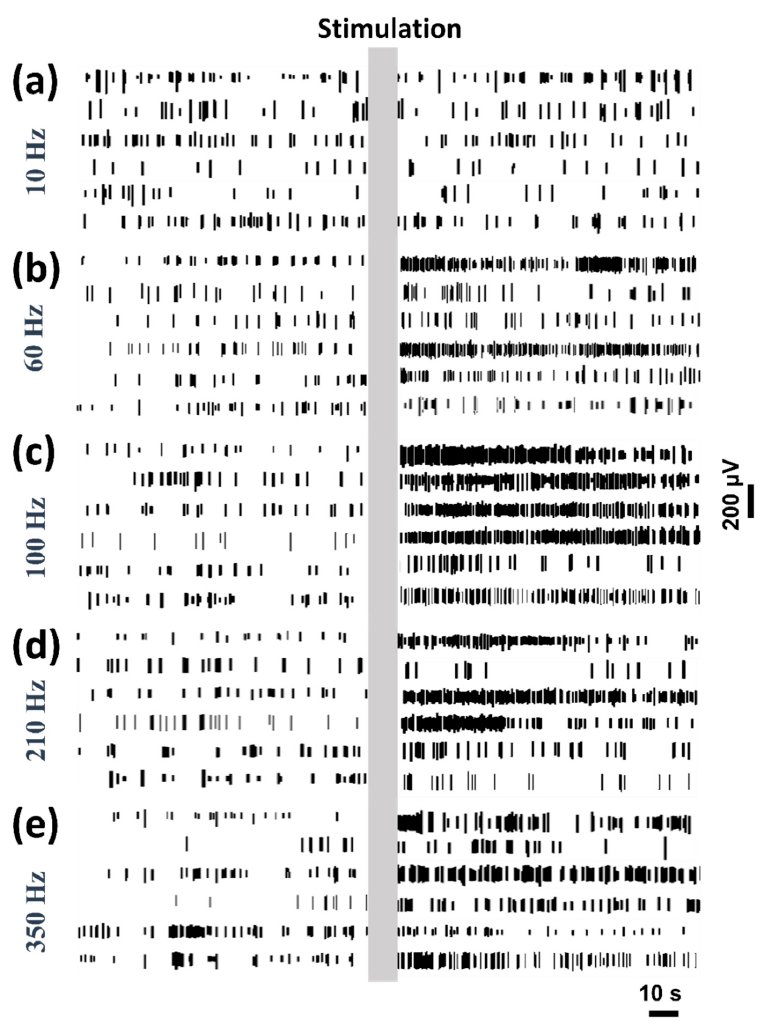
Figure 3. The neural spike firing variations during deep brain stimulation (DBS) with different frequencies of 10 ( a ), 60 ( b ), 100 ( c ), 210 ( d ) and 350 Hz ( e ). The stimulation (300 µ A intensity, 10 s duration and 60 μ s pulse width) is presented with the gray box.